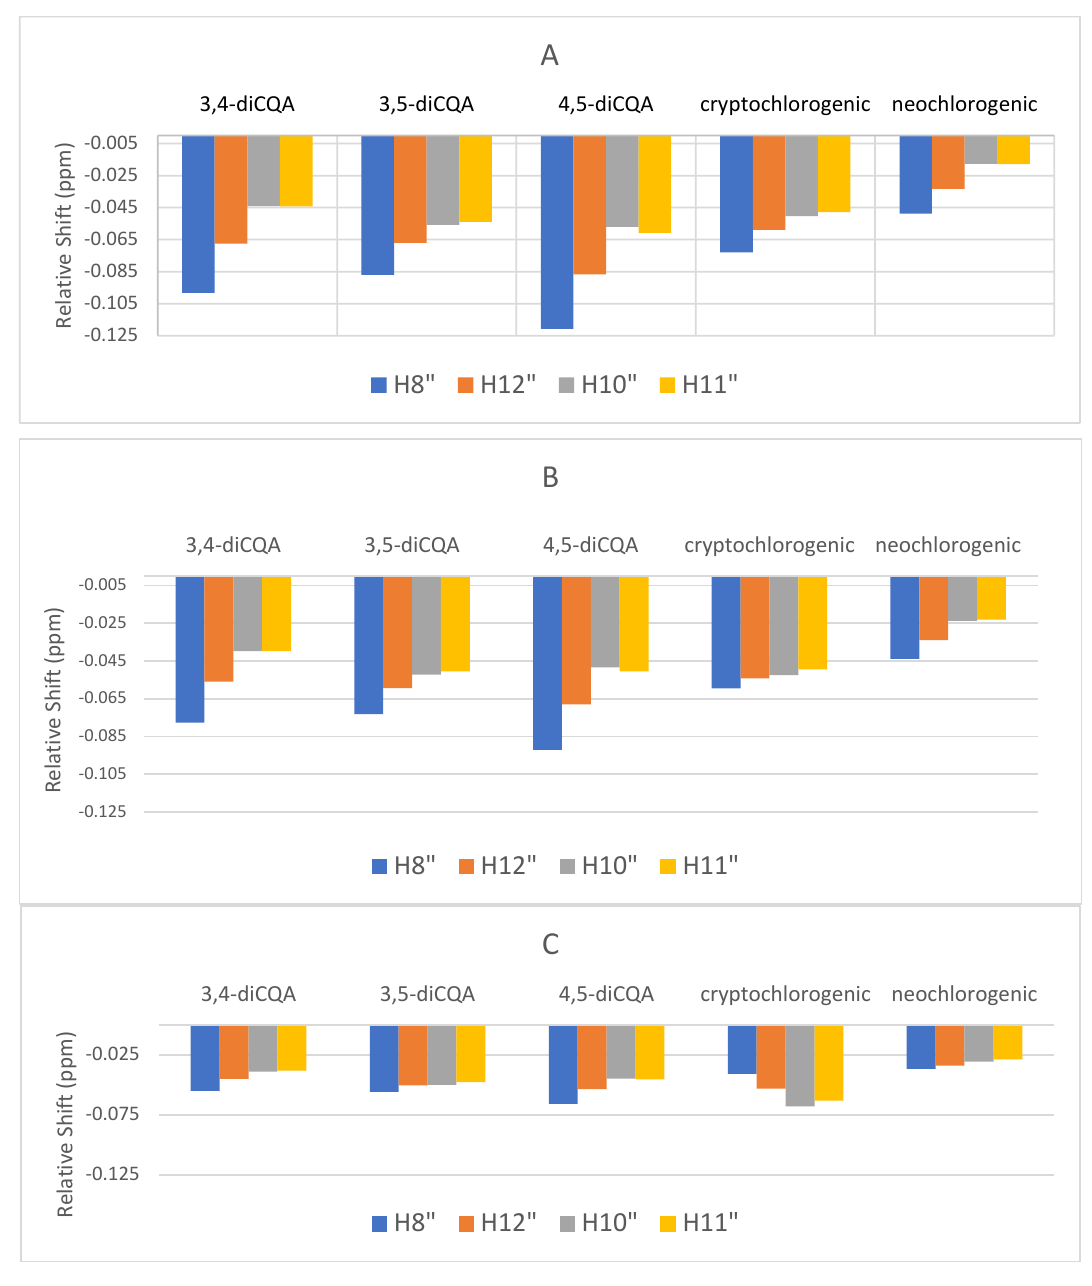
Figure 6. Superimposed 1 H NMR spectra of 3,4-diCQA (3.4 mM) with sequential addition of caffeine (0 mM, 9 mM, 27 mM, and 45 mM) .